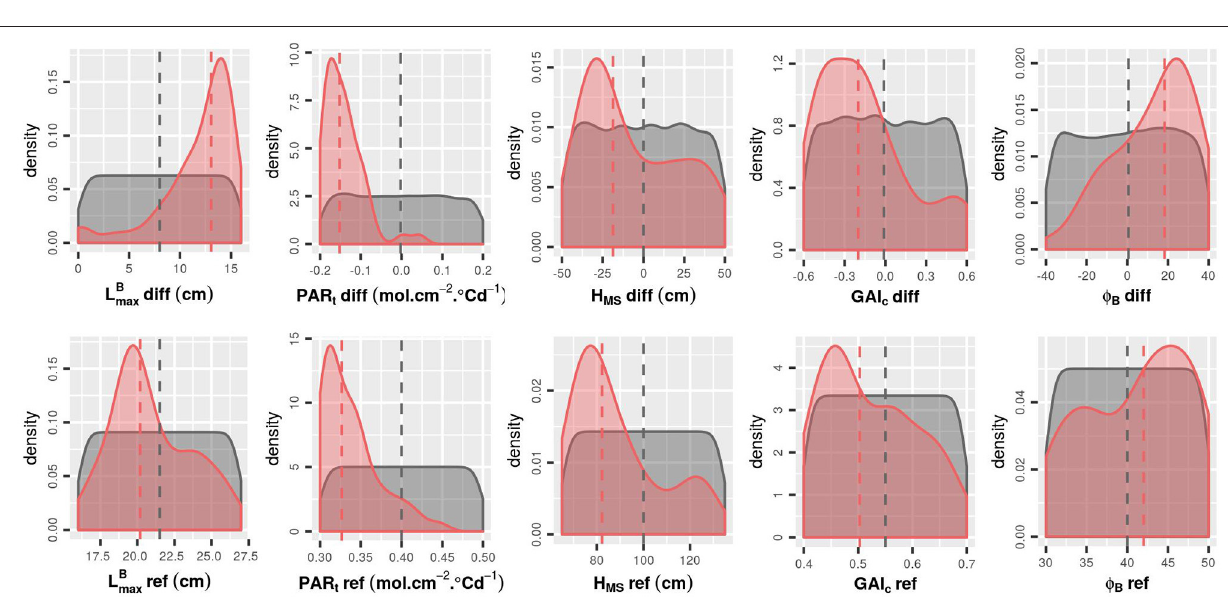
FIGURE 6 | Density of each input factor for the initial LHS (gray) and for the 50 runs with the highest F tot values (red). The medians for each group are represented by a dashed line. To avoid redundancy in the combinations of parameters, results are represented only with positive values of L B max